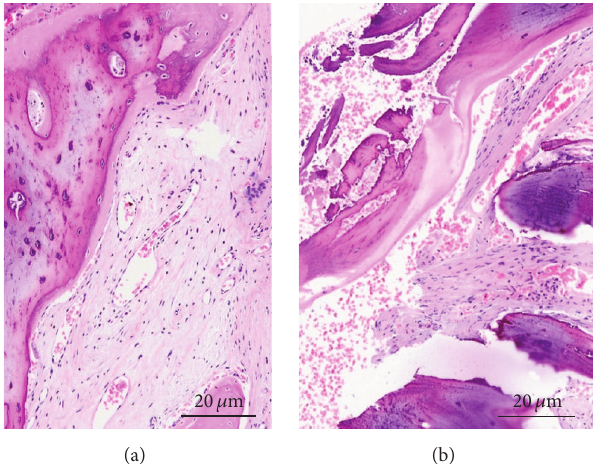
Figure 4: Bone biopsy illustrating socket healing 4 months after the ridge reconstruction procedure. Hematoxylin and eosin staining. Total magnification: × 100 ((a), central incisor; (b), lateral